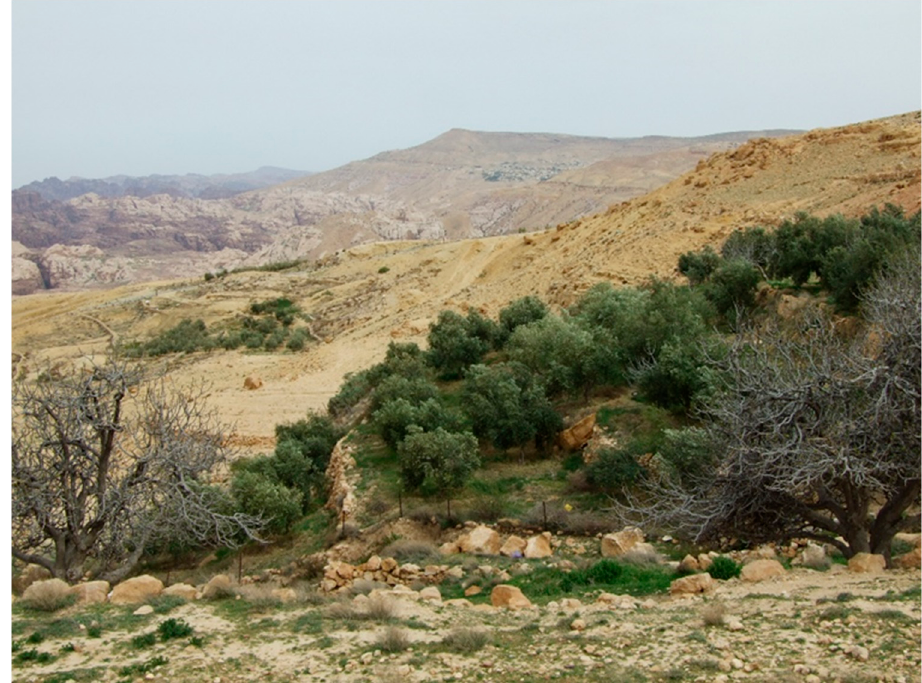
Figure 6. General view of the Petra region from the south. Note that the sandstone units exposed in the slopes of the high mountain range of Gabel Ash-Sharah consist of Late Cretaceous marine car- bonates that reach an elevation of 1600 (in the background). Terrace farming is practiced along the slopes and valleys, utilizing the fine sediments deposited on the slopes. (Photograph: Y.